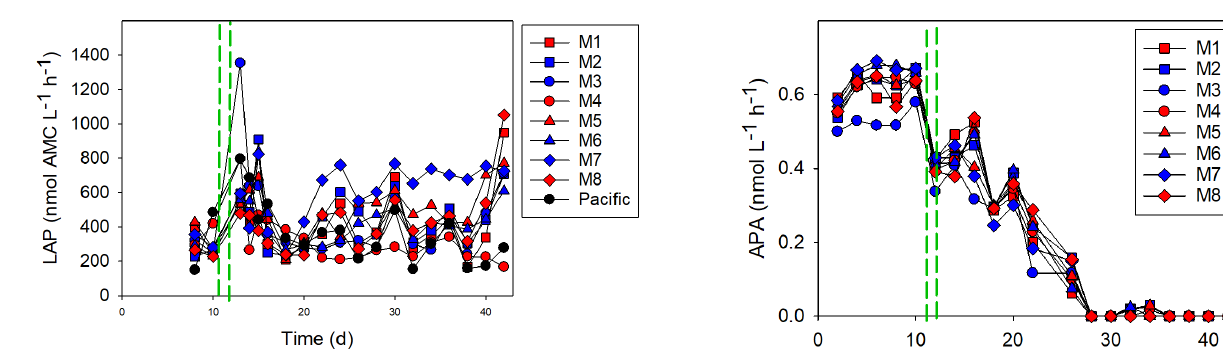
Figure 6. The leucine aminopeptidase (LAP) activity. The red and blue colors denote the mesocosm bags with the addition of water with a low (closer to shore) and very low (further offshore) oxygen minimum zone (OMZ) signature, respectively. The green dashed lines denote the time of OMZ-water addition. Pacific denotes mea- surements from water collected next to, but outside of, the meso- cosms.